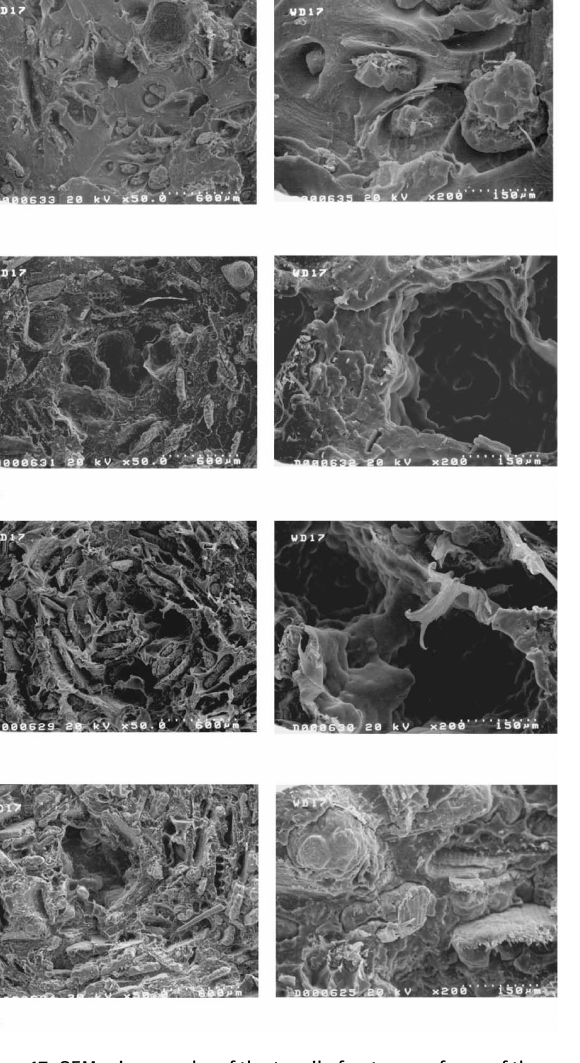
Figure 18: SEM image of 20% RH reinforce polypropylene showing presence of voids